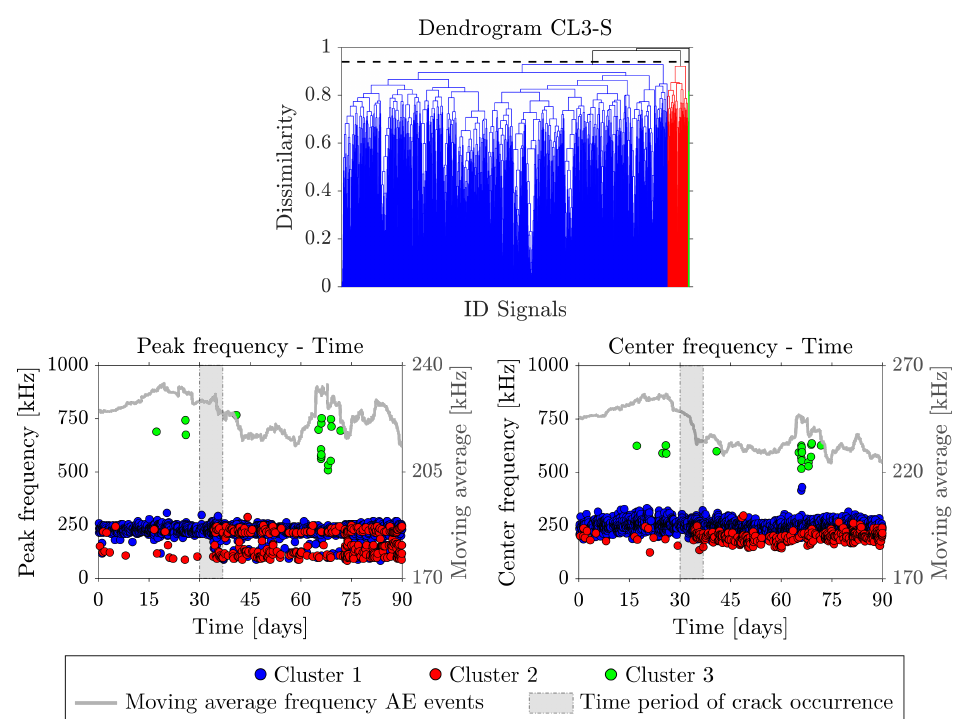
Figure 5. Clustering result of sample CL3-S with ( top ) dendrogram, ( bottom left ) peak frequency versus time, and ( bottom right ) center frequency versus time. The period in which the surface crack occurred is indicated by the grey